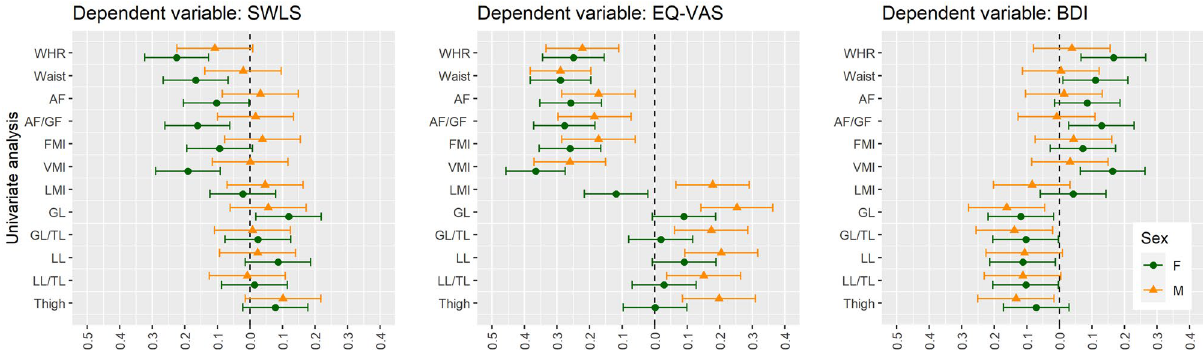
Figure 1. Univariate linear regression analysis between body composition and subjective well-being scores in non-obese women and men. SWLS Satisfaction with Life Scale, EQ-VAS Euro Quality of Life Visual Analogue Scale, BDI Beck Depression Inventory, WHR waist-hip ratio, AF android fat, AF/GF android fat/gynoid fat, FMI Fat Mass Index, VMI Visceral Mass Index, LMI Lean Mass Index, GL gynoid lean, GL/TL gynoid lean/total lean, LL legs lean, LL/TL legs lean/total lean, F female, M male.